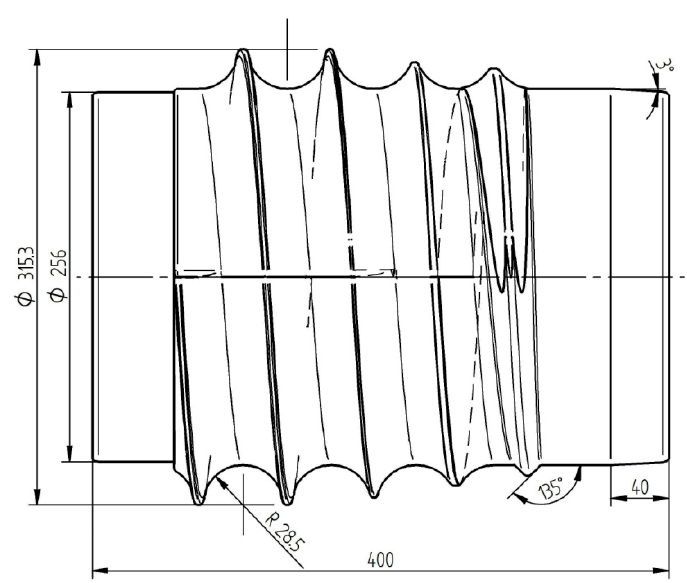
Figure 6. Helical roll for rolling Ø57 mm diameter balls, with the selected dimensions in mm given.